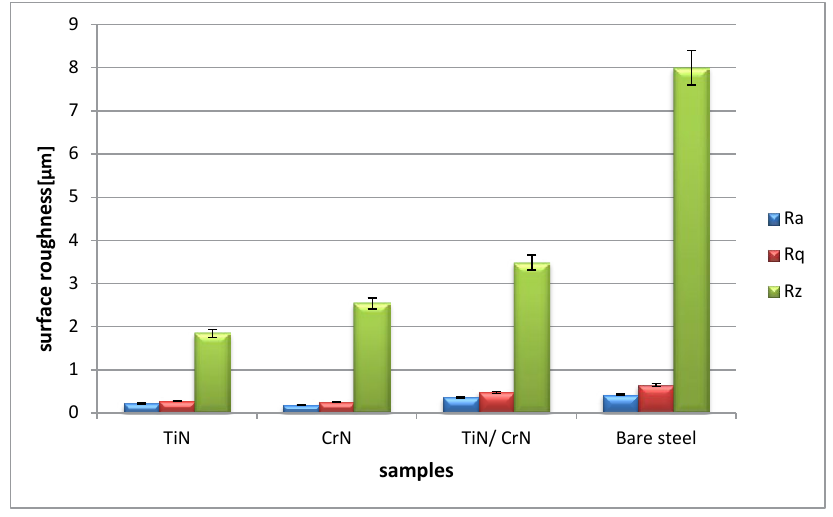
Fig. 6. Ra, Rq and Rz values for the examined samples. Error bars are standard deviations